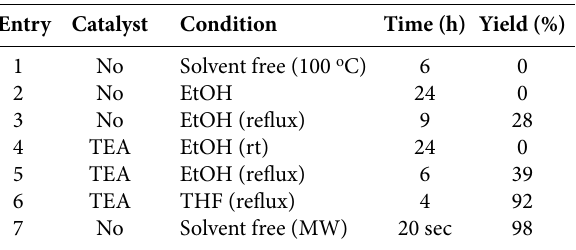
Table 1. Comparison of different conditions for the synthesis of ( E )- 2-cyano- N’ -(pyridin-4-ylmethylene)acetohydrazide ( 1 ) Entry Catalyst